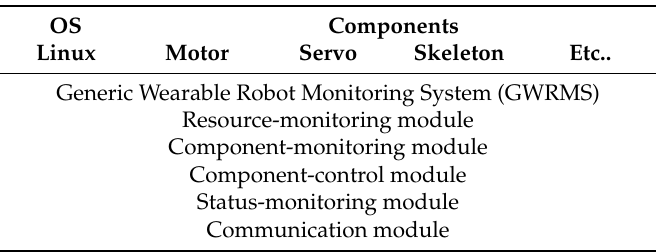
Table 2. Components of the wearable robot that communicate with GWRMS.